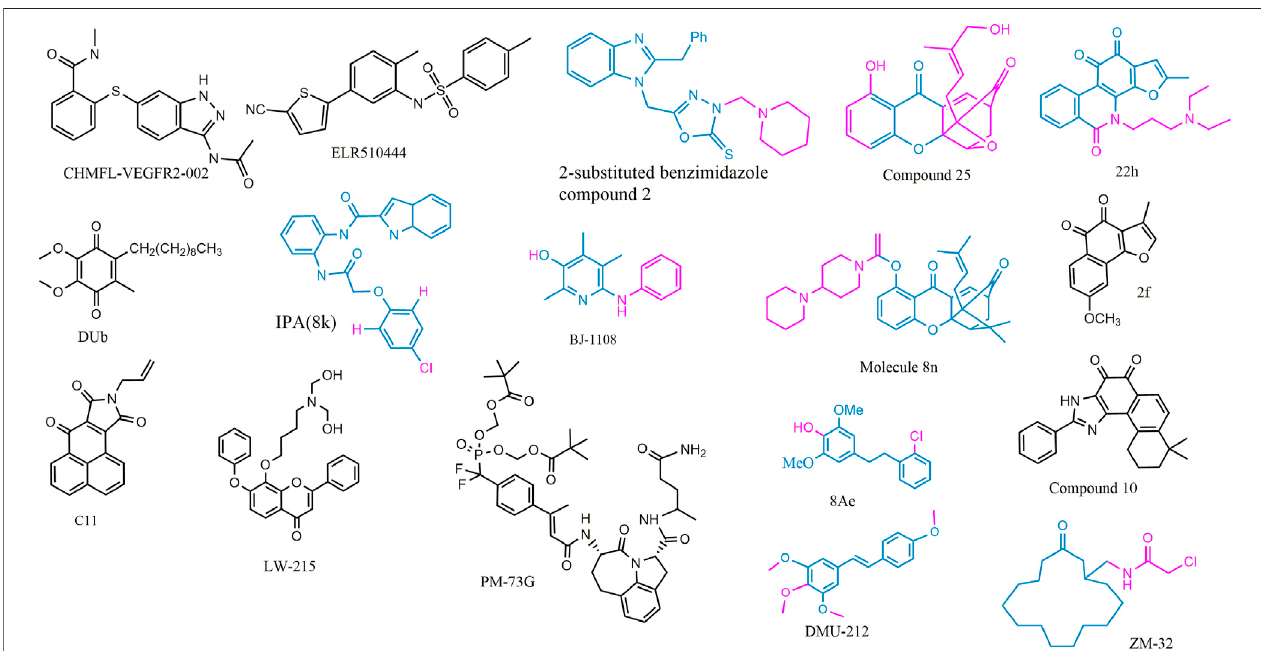
FIGURE4| 2Dstructure ofpotentialchemicals withanti-angiogenesis. Thestructure – activity relationshipin coloringmolecules wasinvestigated:blue (parent) and red (substituent position).